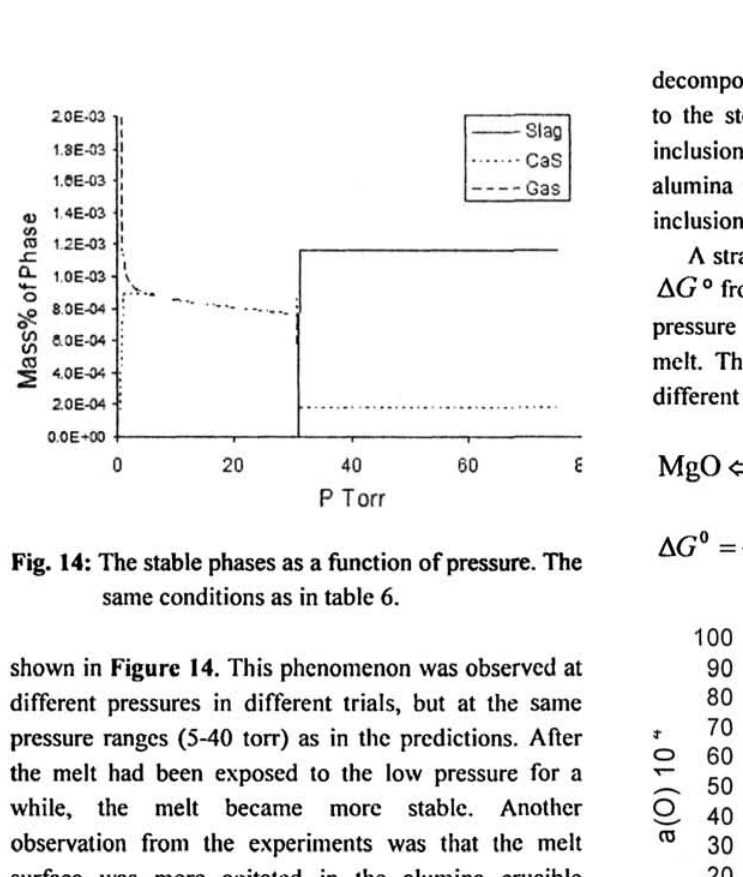
Fig. 14: The stable phases as a function of pressure. The same conditions as in table 6.